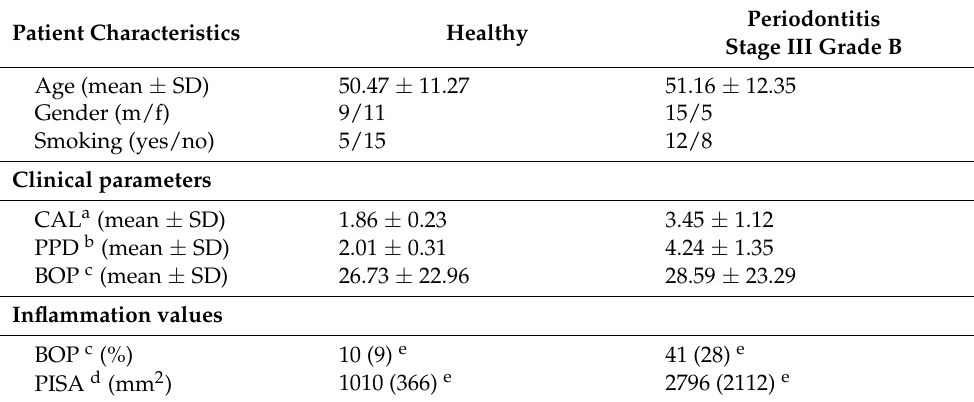
Figure 1. Reagent strip (Combur9-Test Cobas test strips) performed on saliva samples in order to determine: pH, leukocytes, erythrocytes, levels of nitrites, proteins, glucose, ketone bodies, urobilinogen, and bilirubin. ( A ) Blank test strip; ( B ) control with 10 µ L water/test field each; ( C ) saliva sample 10 µ L/test field each; ( D ) color reference. Table 1. Descriptive statistics of patient characteristics, clinical parameters, and a comparison of inflammation values of bleeding on probing (BOP), and periodontal inflamed surface area (PISA) as median (IQR) in healthy and periodontal patients (the statistical significance level was set at α ≤